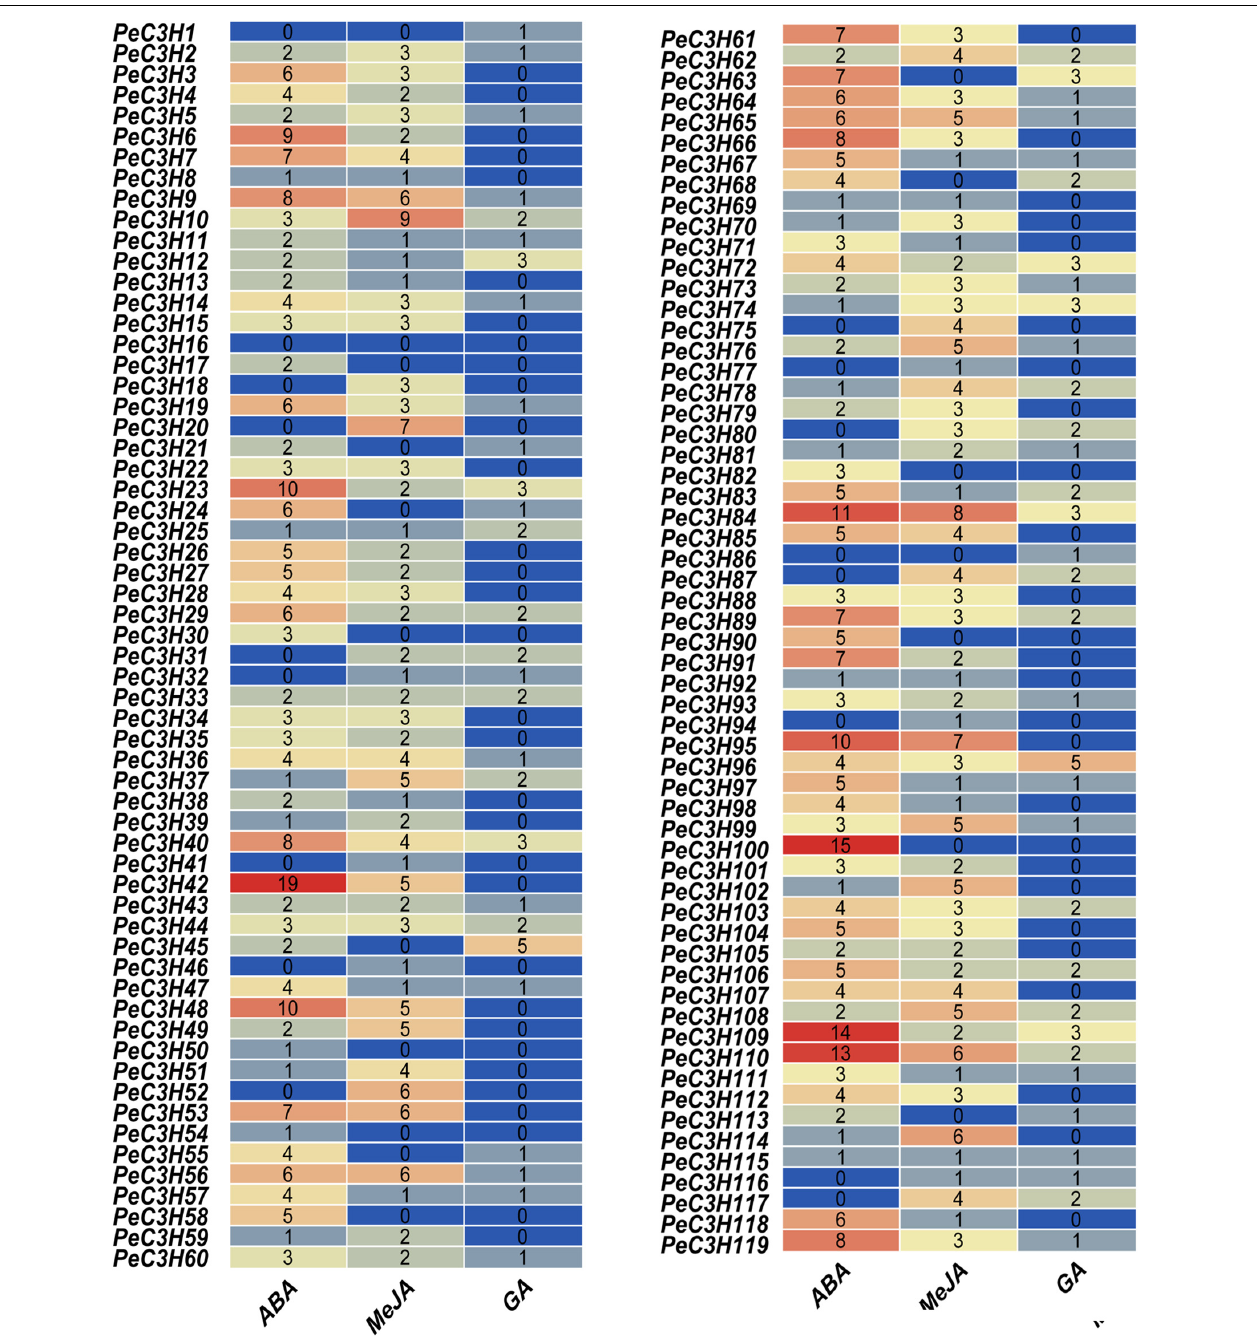
FIGURE 3 | The position of moso bamboo CCCH genes abscisic acid (ABA), Me-JA, and GA in promoter. ABA was shown in red. Me-JA was shown in yellow. GA was shown in blue.